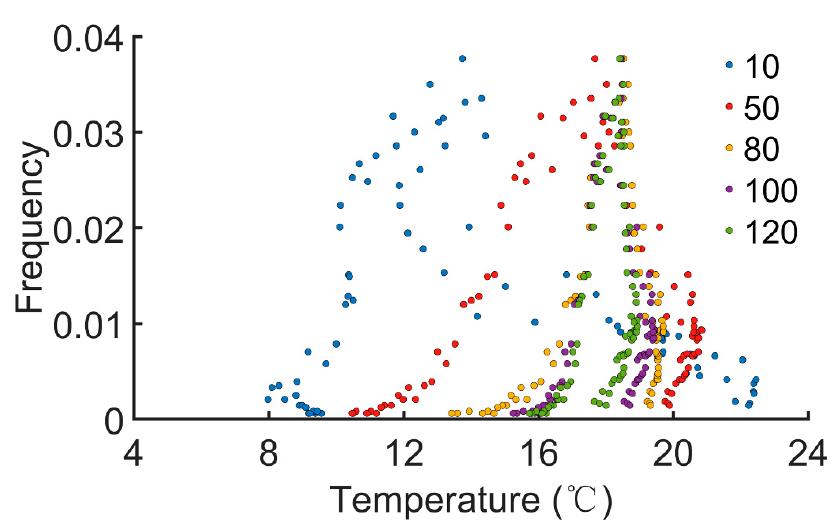
Figure 5. The relation between daily average effective accumulated temperature and pest outbreaks. EAT(°C ∙ day) is defined as ∑ ( T − B ) , where T i is the (average) daily temperature of the i th day, and B is the baseline or developmental threshold temperature. The duration of record ‘ n ’ is varied from 10, 50, 80, 100, to 120